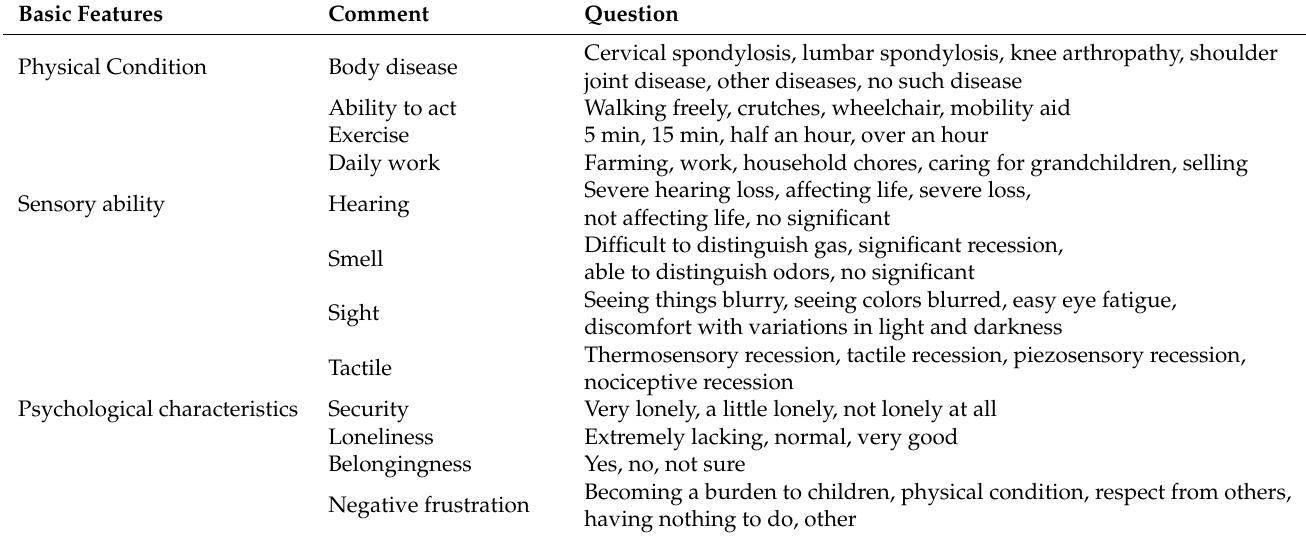
Table 1. Content of interviews with the elderly in ancient towns.